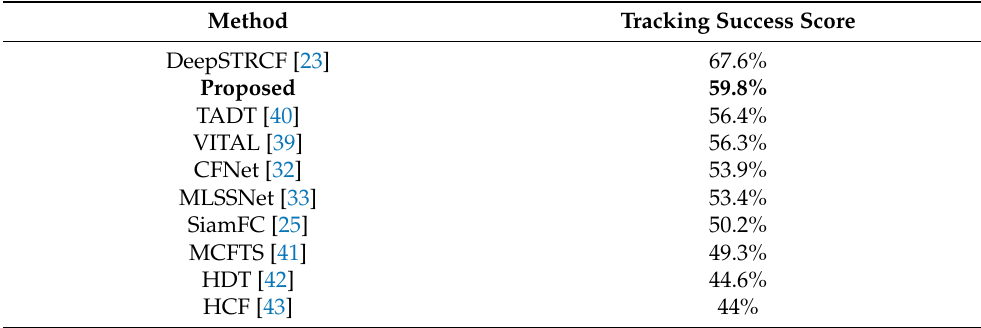
Table 4. Evaluation with respect to the success score.